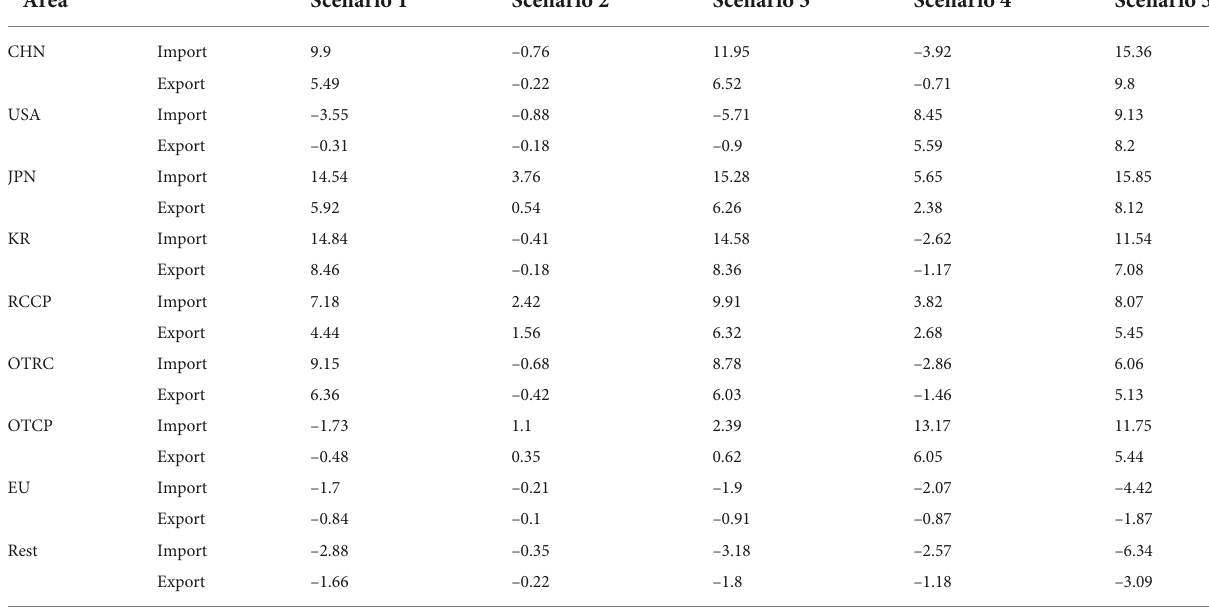
TABLE 5 Impact on imports and exports